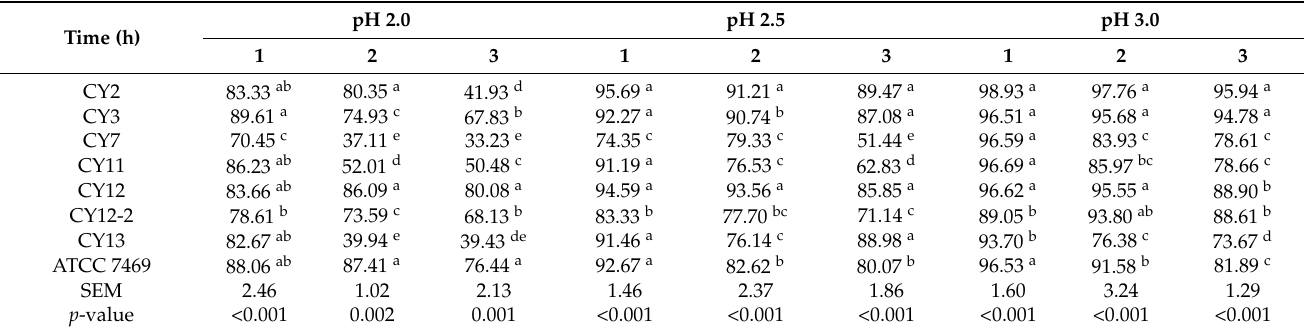
Table 4. Effect of simulated gastric juice on the viability of Lactobacillus